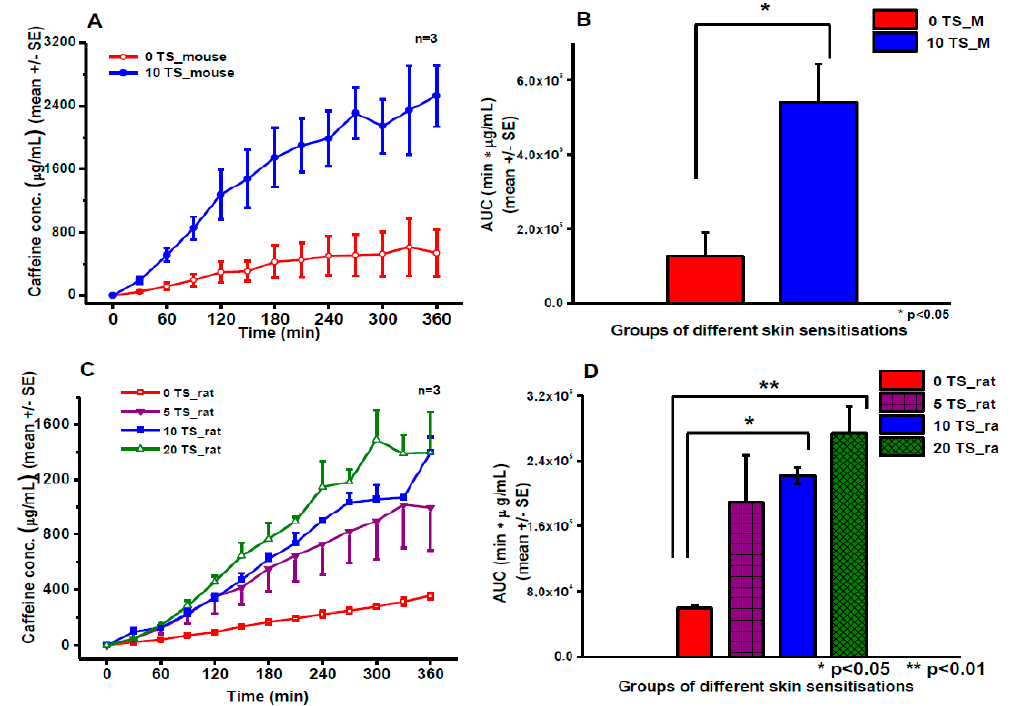
Figure 6. Transdermal caffeine absorption from a cream formulation studied in Franz diffusion cells. Concentration-time profiles of caffeine absorption in mouse ( A ) and rat ( C ) skin preparations. Area under the curves (AUCs) of concentration-time profiles in mouse ( B ) and in rat ( D ). 0TS: native skin without tape-stripping, 5-10-20TS: sensitized skin with 5-10-20 tape-strippings. N = 3, *: p < 0.05, **: p < 0.01 in two-sample student t -test.